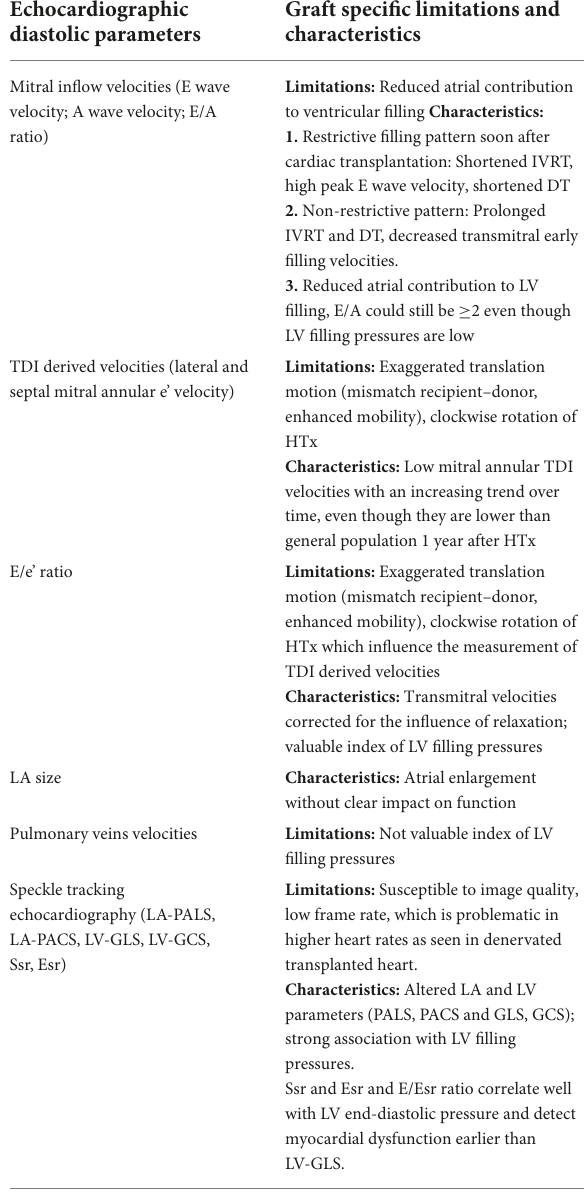
TABLE 2 Advantages and disadvantages of echocardiography-derived diastolic parameters in heart transplant. Echocardiographic diastolic